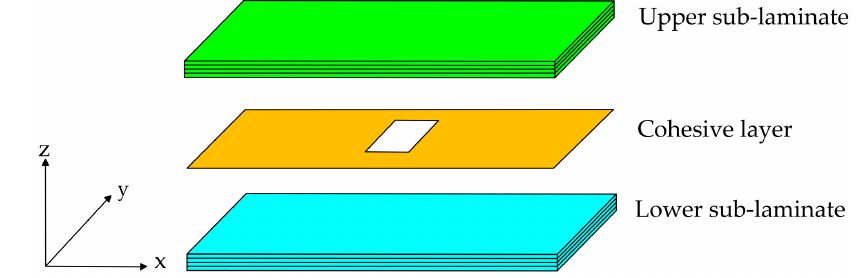
Figure 7. Schematic diagram of the delamination damage structure model.